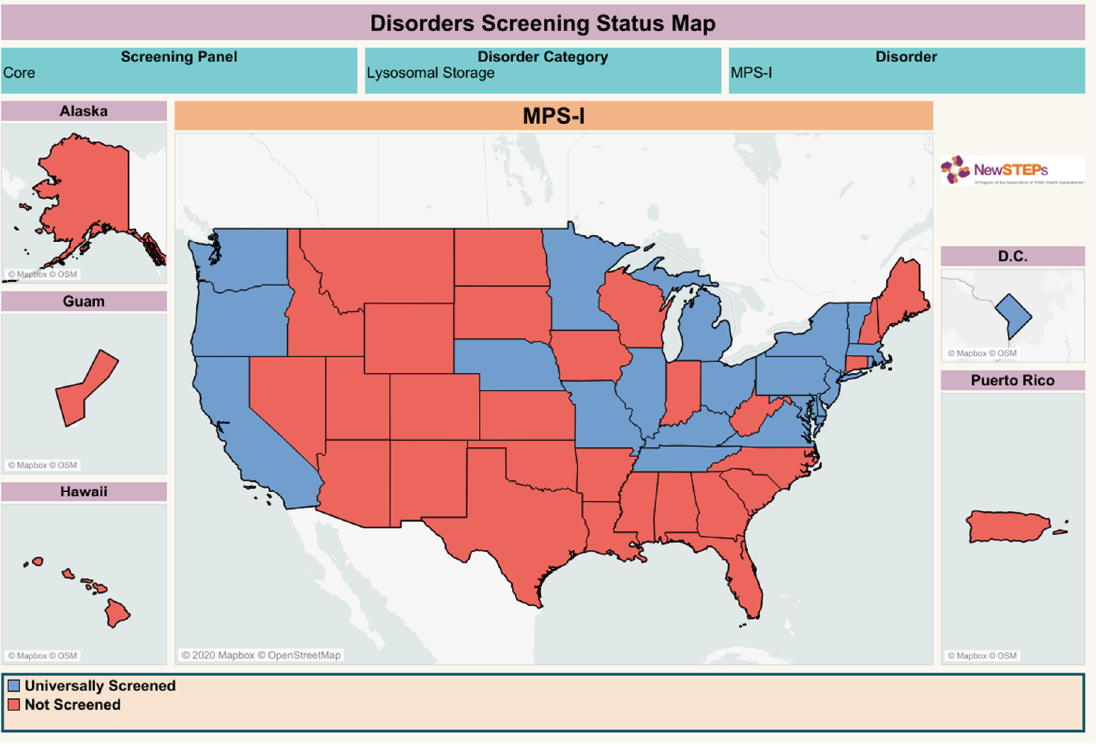
Figure4. StatusoftheMPSINBSintheUnitedStates.CurrentstatusavailablefromtheNewSTEPs(https: Figure 4. Status of the MPS I NBS in the United States . Current status available from the NewSTEPs // www.newsteps.org / resources / newborn-screening-status-all-disorders, Accessed: 14 March (https://www.newsteps.org/resources/newborn-screening-status-all-disorders, Accessed: 14 March 2020).